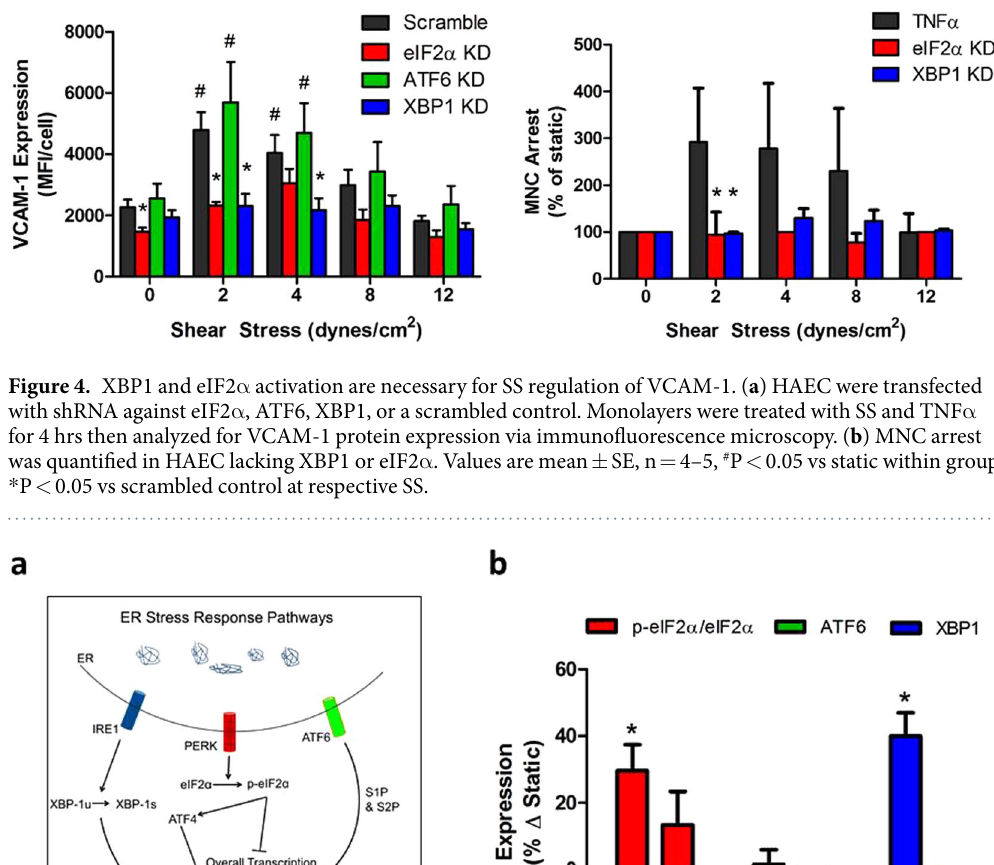
were suppressed. In contrast, significant changes in ATF6 were not observed along the SS gradient. We conclude that VCAM-1 expression is mechanoregulated through activation of the eIF2 α and XBP1 arms of the UPR at atherosusceptible low SS.